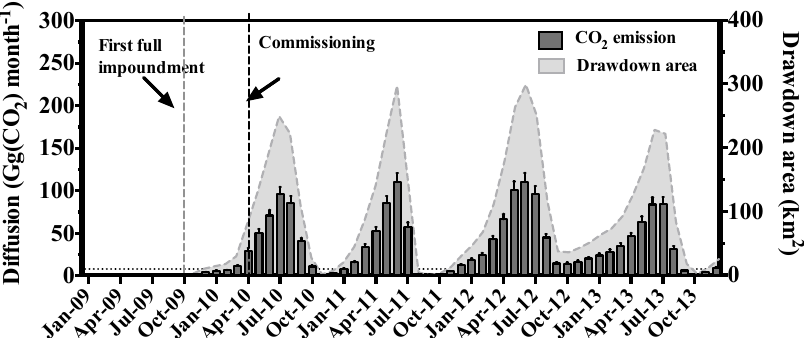
Figure 7. Monthly emissions from the drawdown area and variation in the area of the drawdown of the Nam Theun 2 Reservoir (Lao PDR).